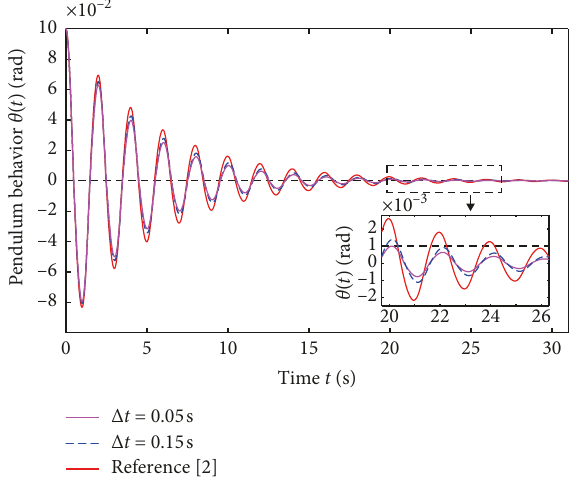
Figure 13: The comparison of the synchronous pendulum Table 1: Amplitudes of the pendulum for 15 cycles.